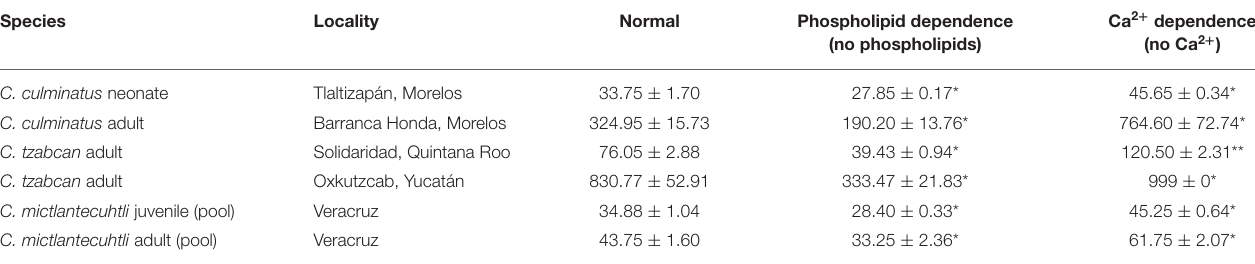
TABLE 4 | Cofactor dependence tests for six representative venoms ( C. culminatus , C. tzabcan , and C. mictlantecuhtli ) incubated with human fibrinogen.